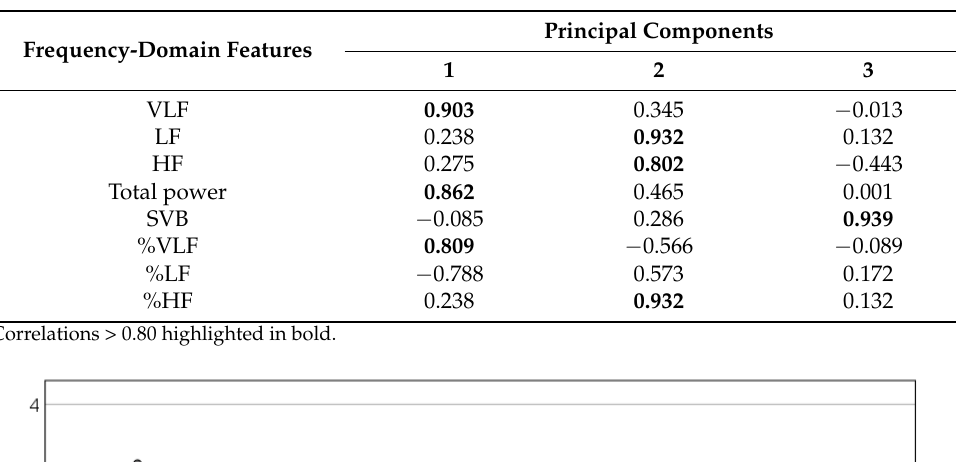
Figure 4. Eigenvalue spectrum for the PCA of the time-domain FHRV features. Table 2. Dimension reduction of frequency-domain features of the FHRV.